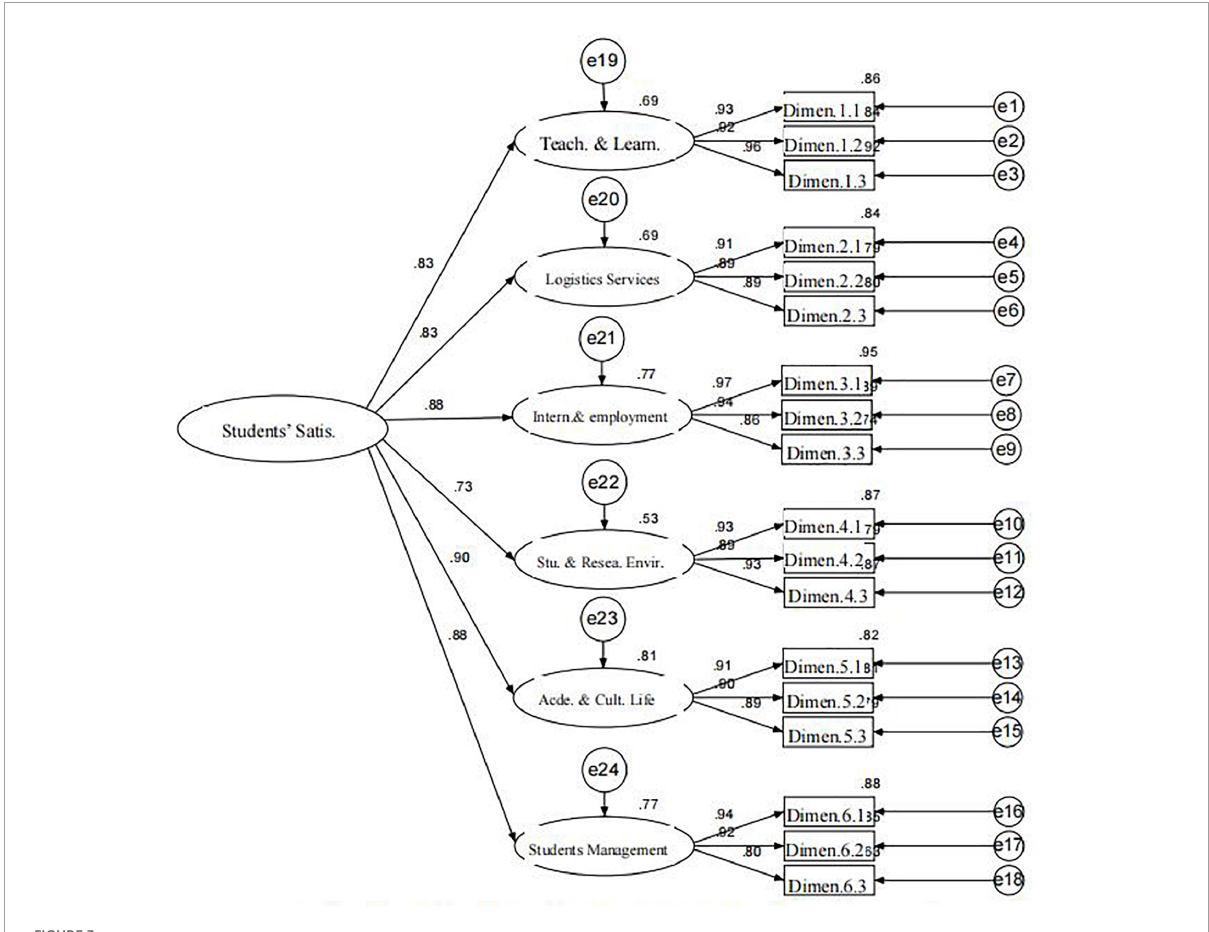
FIGURE3 Standardized estimation model of Chinese University student satisfaction scale.